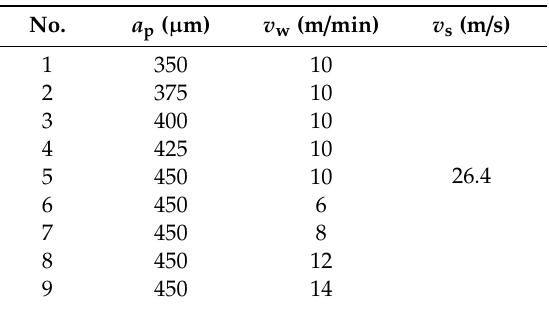
Table 3. Parameters in grind-hardening experiment.